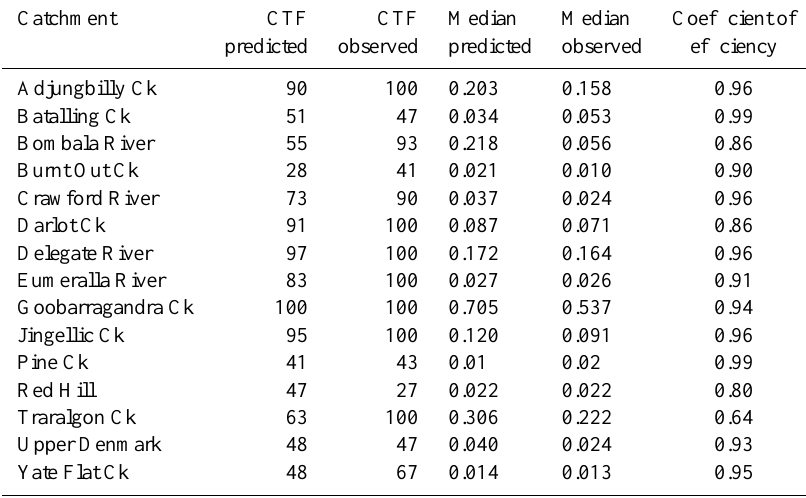
Table 3. Results of FCFC predictions against observations using measured change in mean annual streamflow. Catchment CTF CTF Median Median predicted observed predicted observed efficiency Adjungbilly